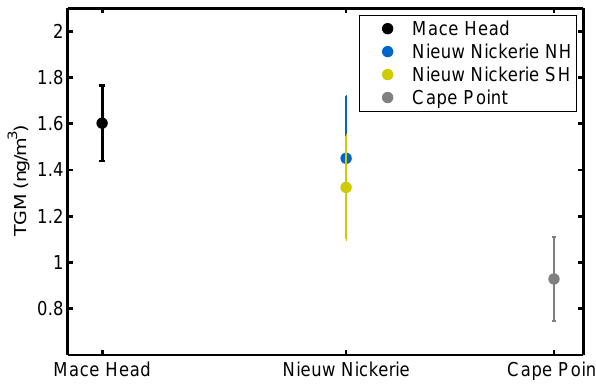
Fig. 5. Annual mean concentrations of total gaseous mercury in 2007 and their latitudinal dependence. The mean for Mace Head was calculated from January–December, the means for Nieuw Nickerie are the same as in Table 1 and hence derived as described in the text. The Cape Point mean was calculated from March– December. The distance between the sites on the horizontal axis corresponds to their distance in latitudes. Error bars represent one standard deviation. Consequently, there is a North-South-gradient, which is true both for this single site, but also if the Nieuw Nickerie SH data are compared to Cape Point as a reference